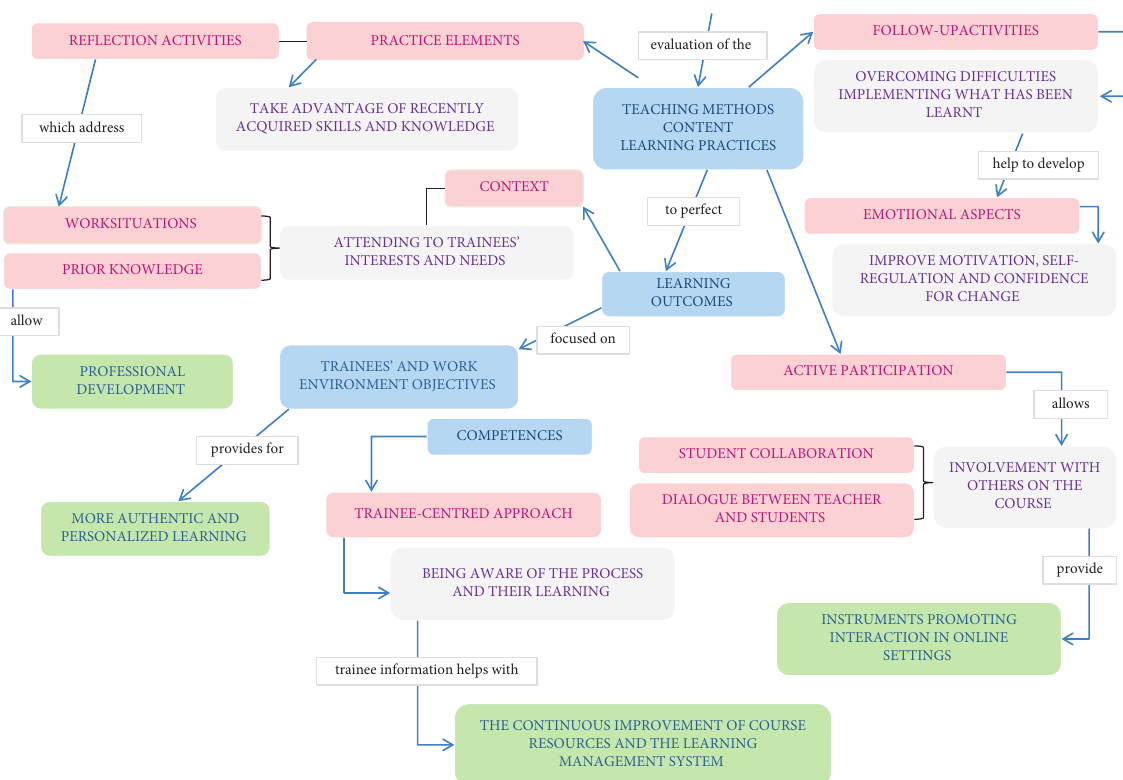
Figure 1: Concept map for the instructional design of an e-learning training course aimed at fostering